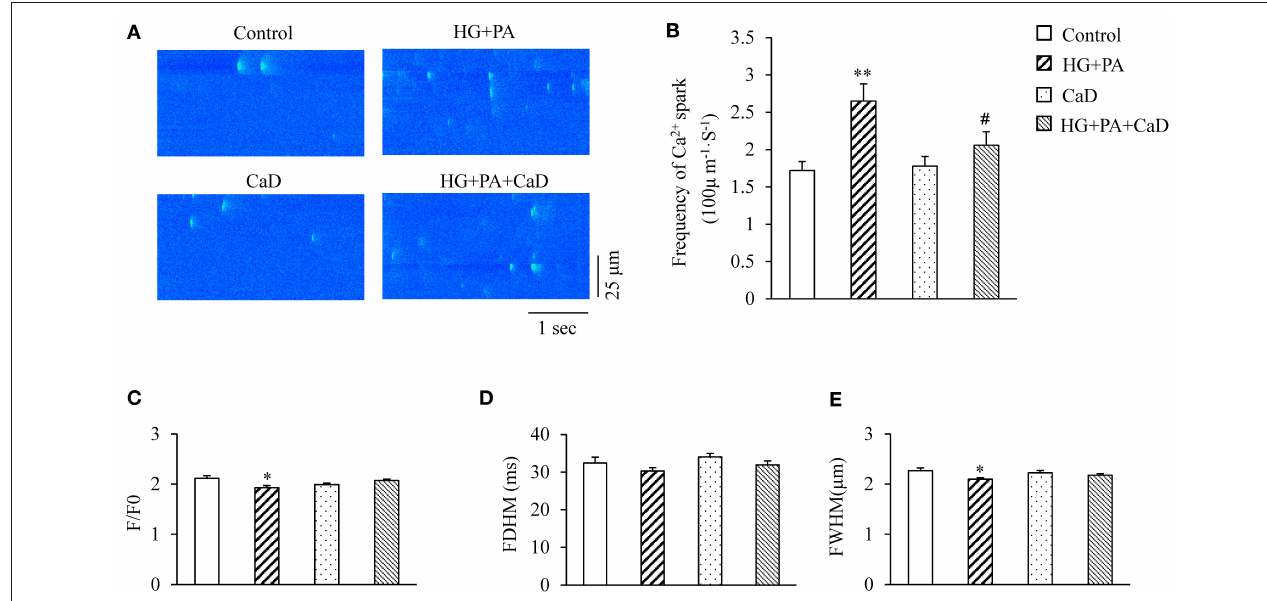
FIGURE 1 | HG + PA increases Ca 2 + sparks frequency in cardiomyocytes. (A) Representative Ca 2 + spark images. (B–E) Statistic analyses of the frequency (B) , amplitude (F/F0, C ), full duration of half maximum (FDHM, D ) and full width of half maximum (FWHM, E ) of Ca 2 + sparks in Control, HG + PA, CaD, and HG + PA + CaD treatments. ** p < 0.01, * p < 0.05 vs. control; # p < 0.05 vs. HG + PA. n =